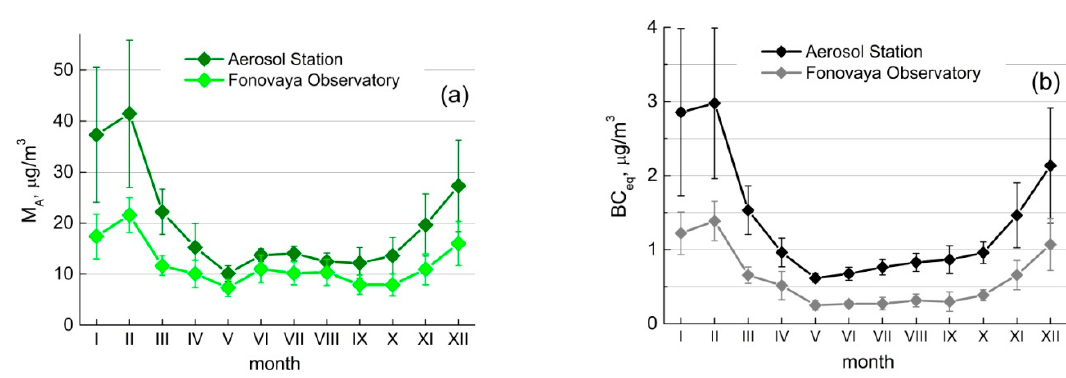
Figure 4. Annually averaged behaviors of mass concentrations of ( a ) submicron aerosol, ( b ) black carbon, and their standard deviations at the Aerosol Station (suburban region) and in the Fonovaya Observatory (background) in 2014–2018. Table 2. Average mass concentrations of submicron aerosol (M A ), black carbon (BC eq ), elemental carbon (EC) ( µ g/m 3 ), and their standard deviation (SD).